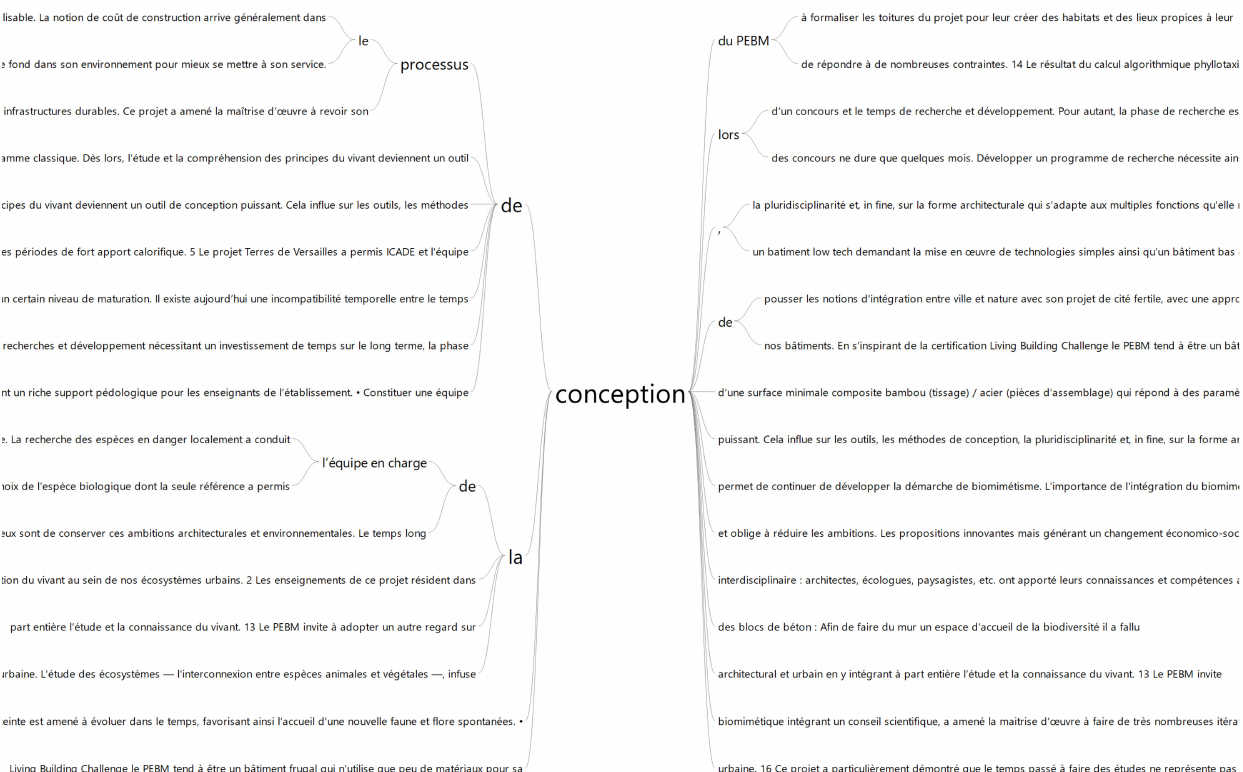
Figure 14. Interactive word tree for “ conception ” using MaxQDA Analytics Pro